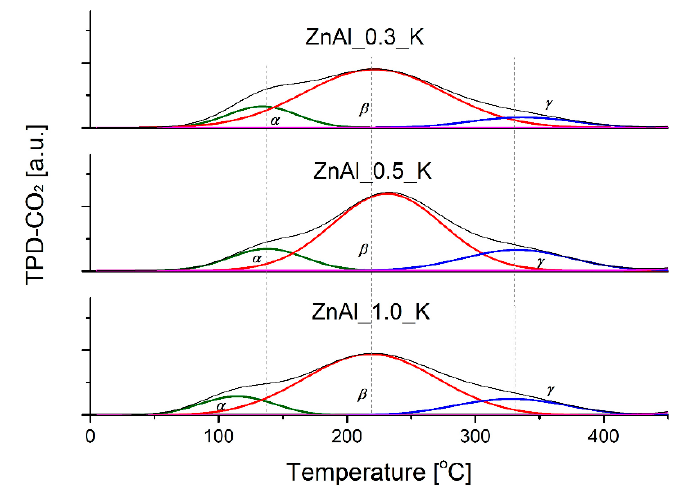
Figure 7. TPD_CO 2 profiles of ZnAl_X_K samples with different Zn/Al molar. ratios.